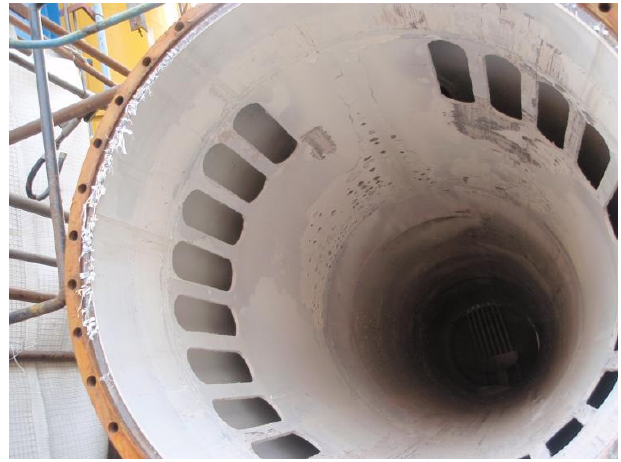
Figure 2. Even corrosion in the pipe.